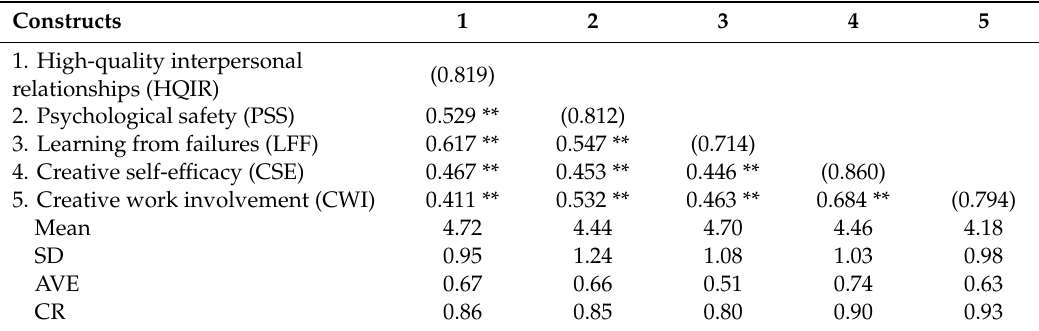
Table 4. Intercorrelations between the salient